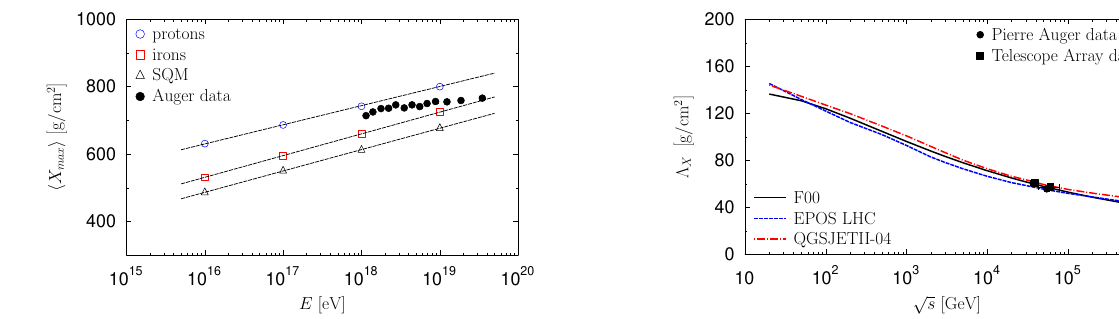
Figure 1. Average position of the shower maximum as a function of the primary energy for EAS generated by protons, iron nuclei, and SQM. Dotted lines show a fit of the type ln . Pierre Auger Collaboration measurements [29] are indicated by black circles.